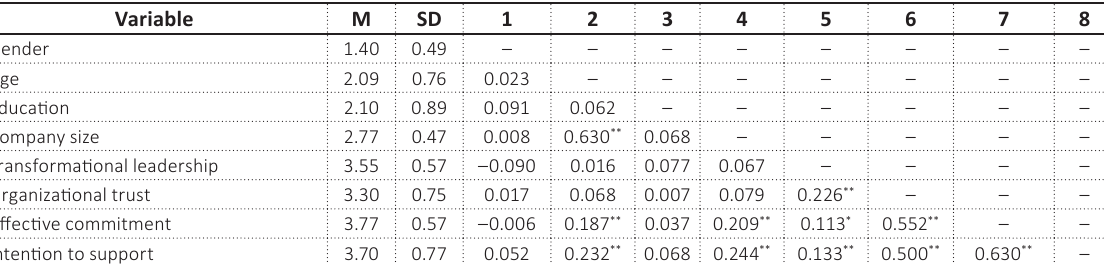
Table 5. Descriptive analysis and